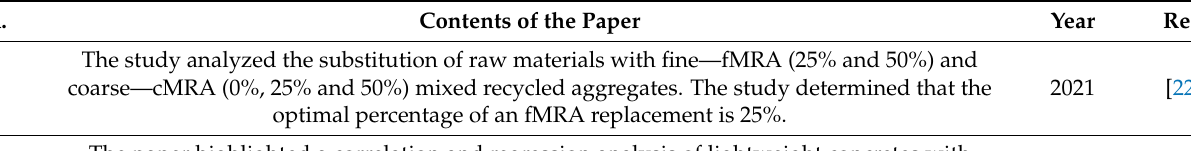
Table 1. Summary of research papers on concrete with waste